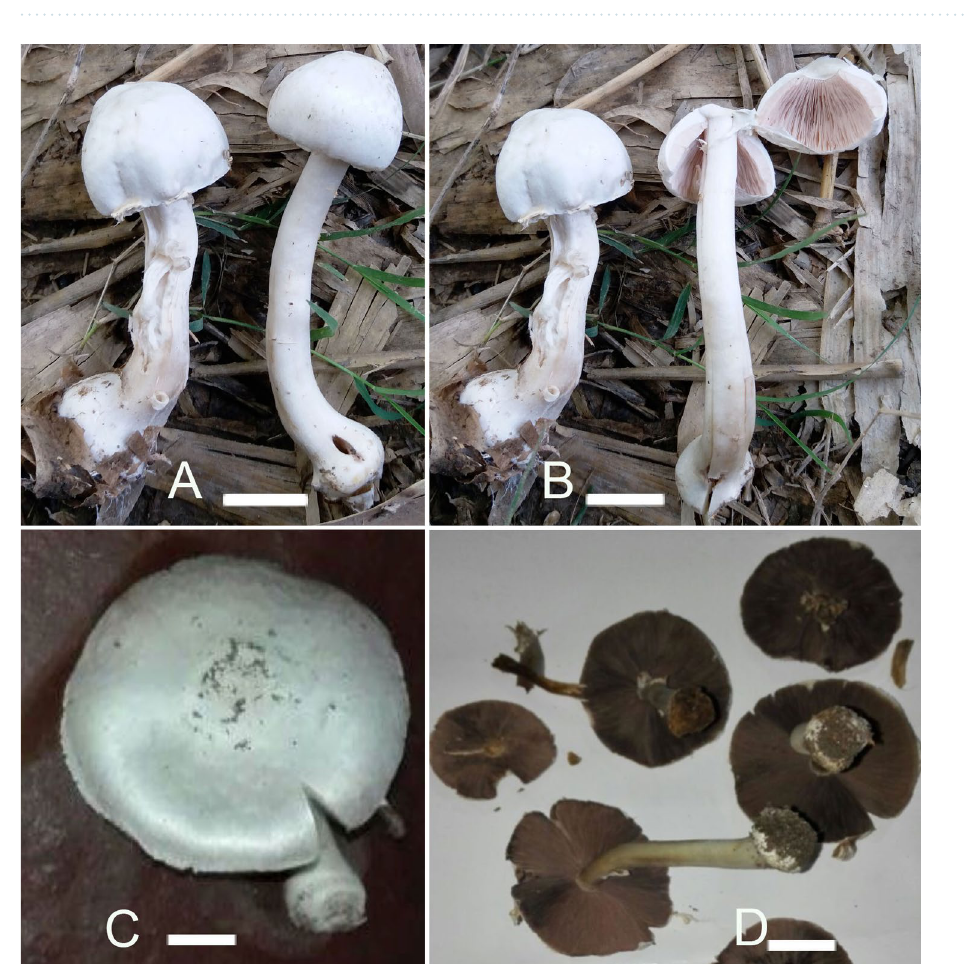
Figure 4. Macromorphological characters of A. bambusetorum. (A–D) basidiomata in the field. (A,B) CM242 ( Holotype ), (C,D) = NWL322. Bars = 1 cm. Photographed by Dr. Hira